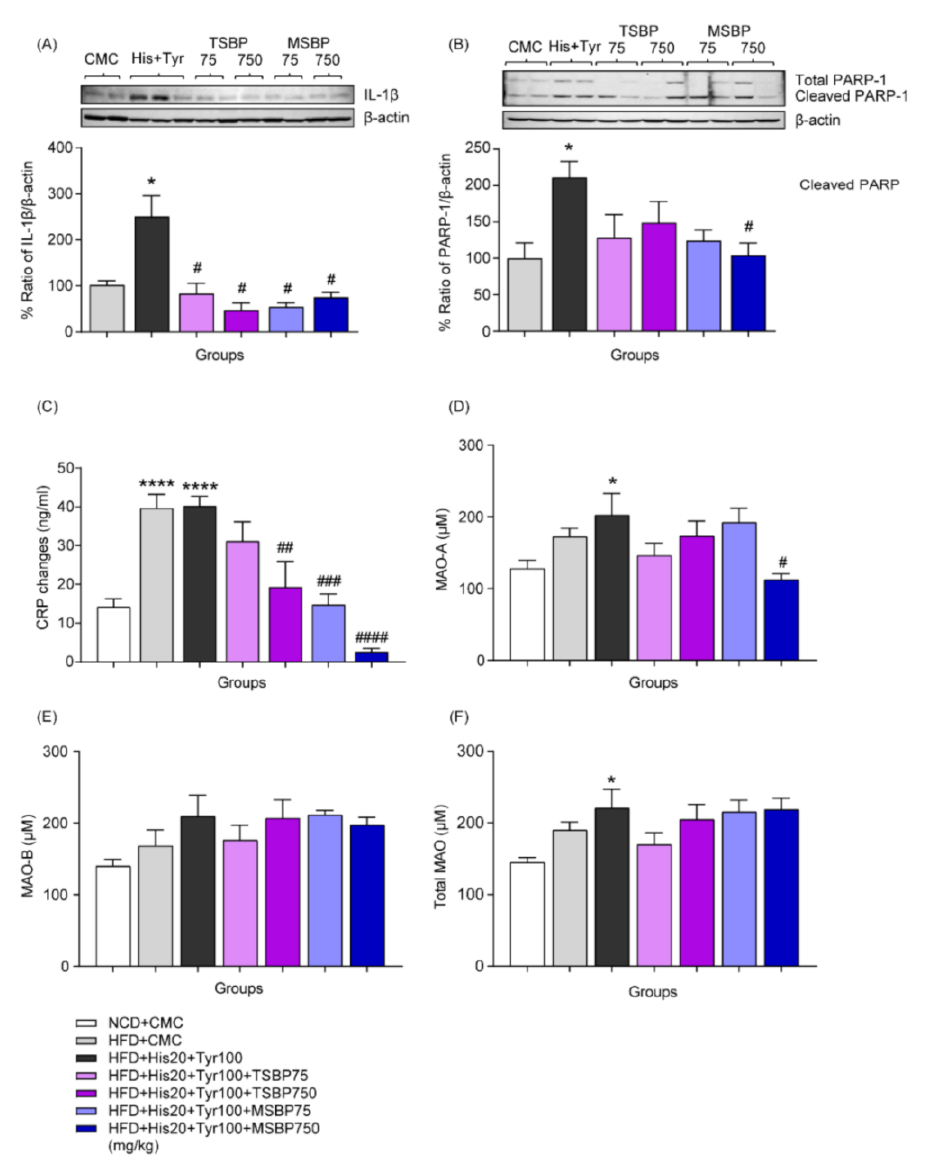
Figure 6. Reduction in biogenic amine-induced hepatic damage by fermented soybean paste in developmental NAFLD. ( A ) Changes in IL-1 β expression levels by biogenic amines and fermented soybean paste in HFD-induced NAFLD liver tissue. ( B ) Changes in cleaved PARP-1 expression levels caused by biogenic amines and fermented soybean paste in HFD-induced NAFLD liver tissue. ( C ) Changes in blood CRP levels caused by biogenic amines and fermented soybean paste in HFD- induced NAFLD. Changes in MAO-A ( D ), MAO-B ( E ), and total MAO ( F ) levels caused by biogenic amines and fermented soybean paste in HFD-induced NAFLD liver tissue. * p < 0.05, **** p < 0.0001, vs. NCD + CMC; # p < 0.05, ## p < 0.01, ### p < 0.001, #### p < 0.0001, vs. HFD + histamine 20